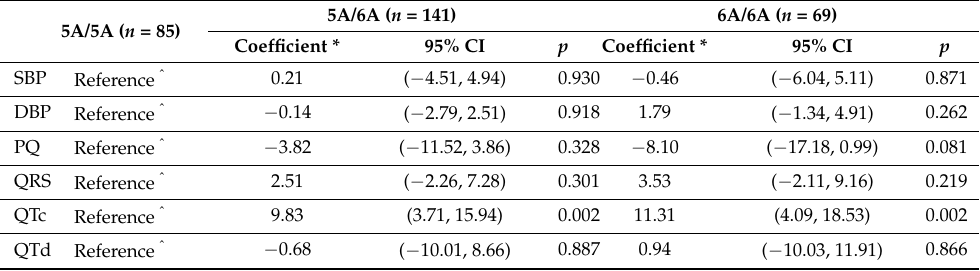
Table 2. Blood pressure and ECG parameters across MMP-3 polymorphisms.